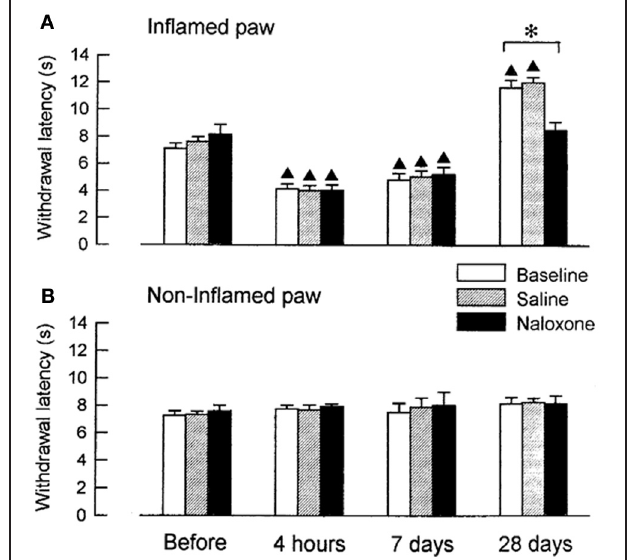
FIGURE 1 | Changes in PWLs following unilateral injection of carrageenan in LC-lesioned ( n = 9) and sham-operated rats ( n = 20). (A) The inflamed paws. (B) The contralateral non-inflamed paws. (cid:2) P < 0 . 01, significantly different from PWLs before injection. ∗ P < 0 . 01, significantly different between two groups of rats (Tsuruoka and Willis, 1996b).